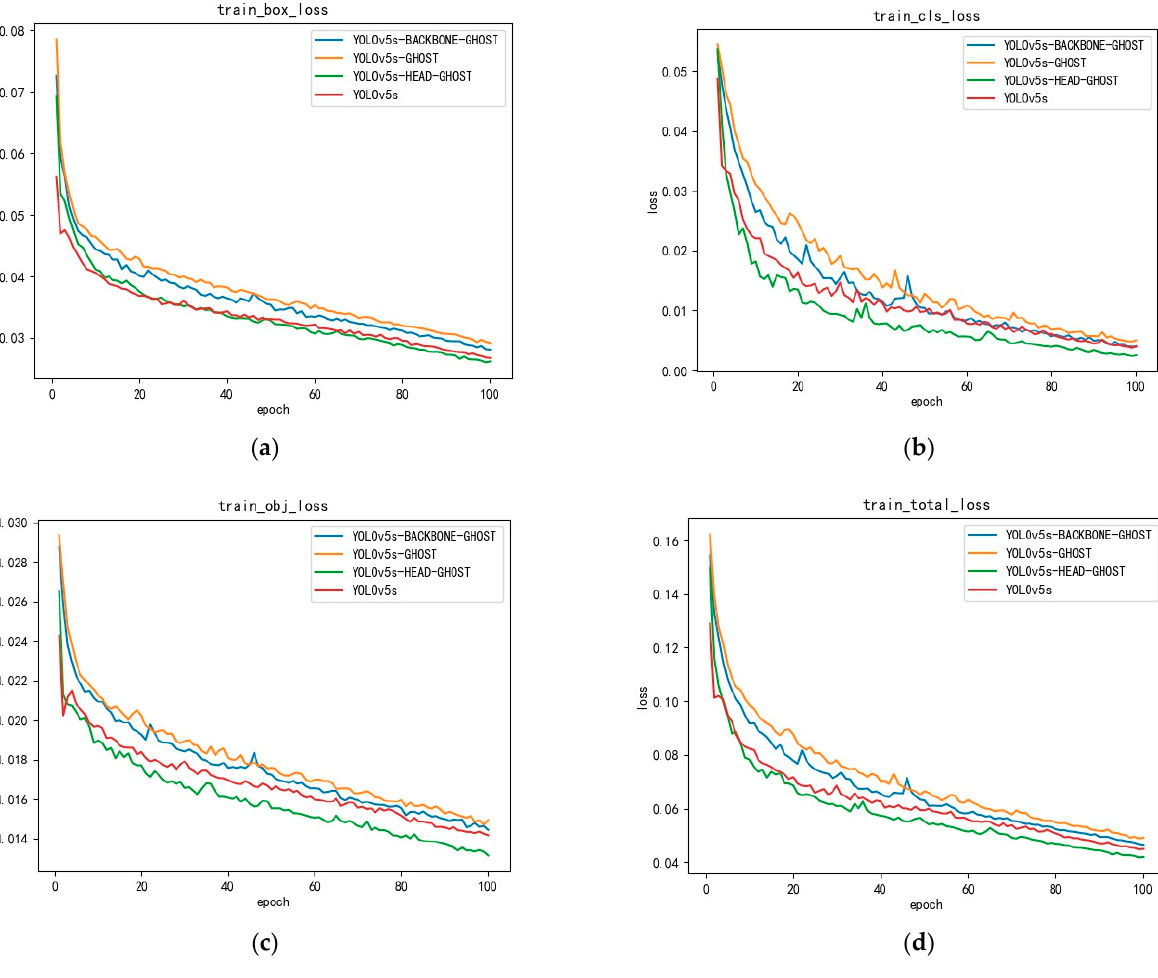
Figure 9. Train loss curve: ( a ) is the box loss, ( b ) classify loss, ( c ) object loss, ( d ) total loss.